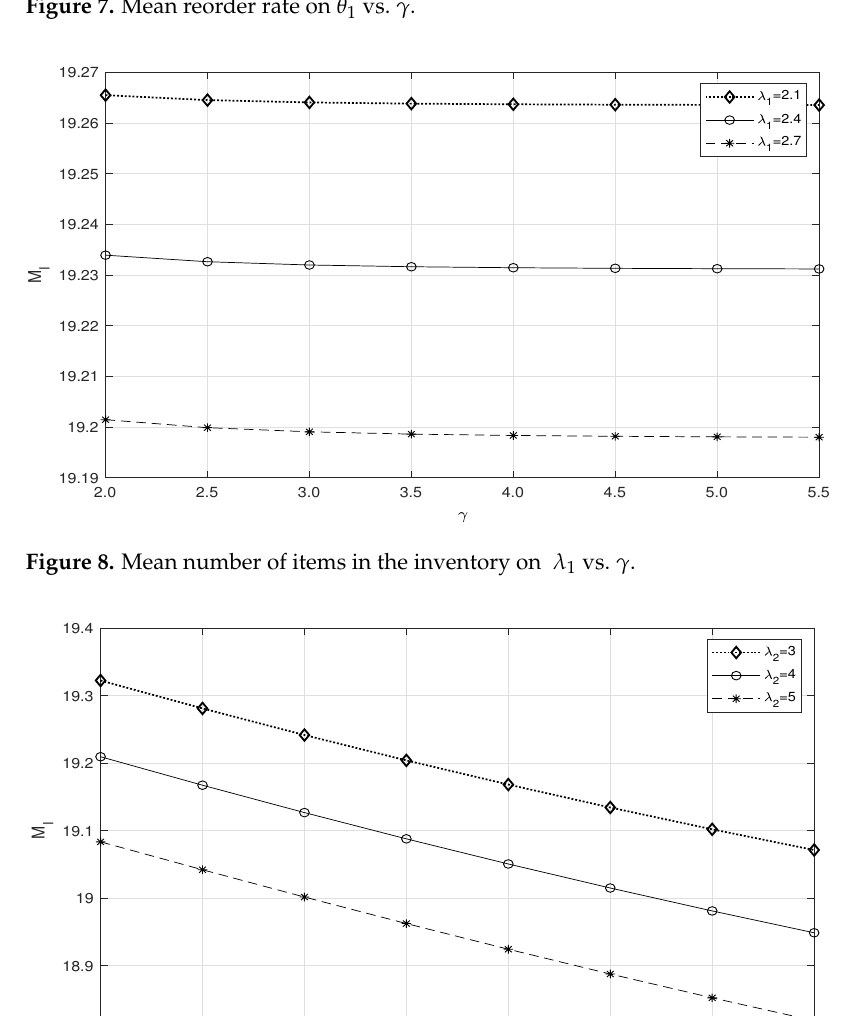
Figure 7. Mean reorder rate on θ 1 vs. γ .